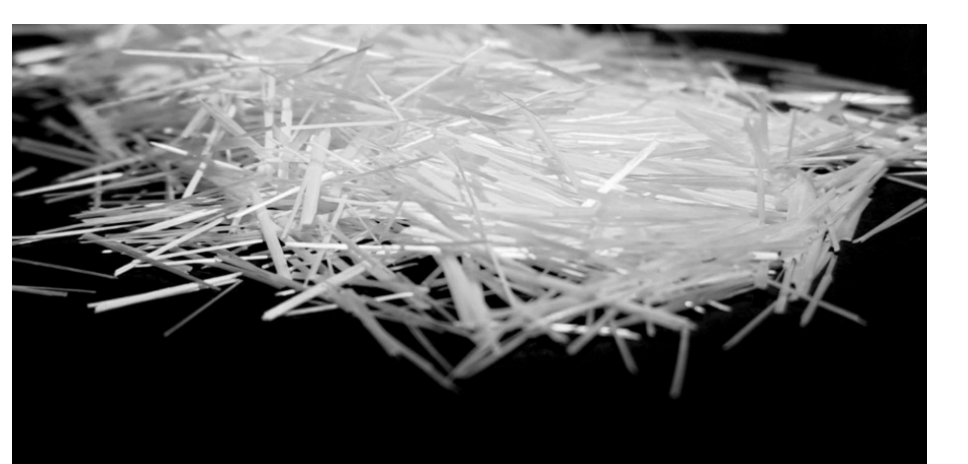
Figure 3. Glass fibers reinforcement.